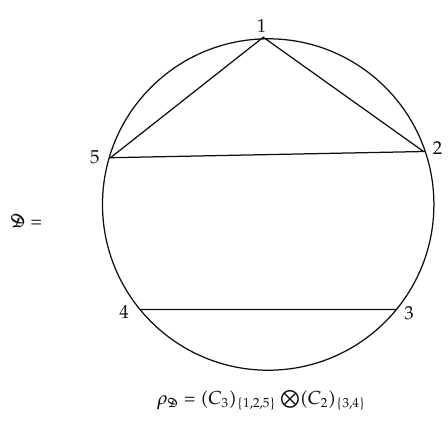
Figure 2: A non-intersection polygon diagram